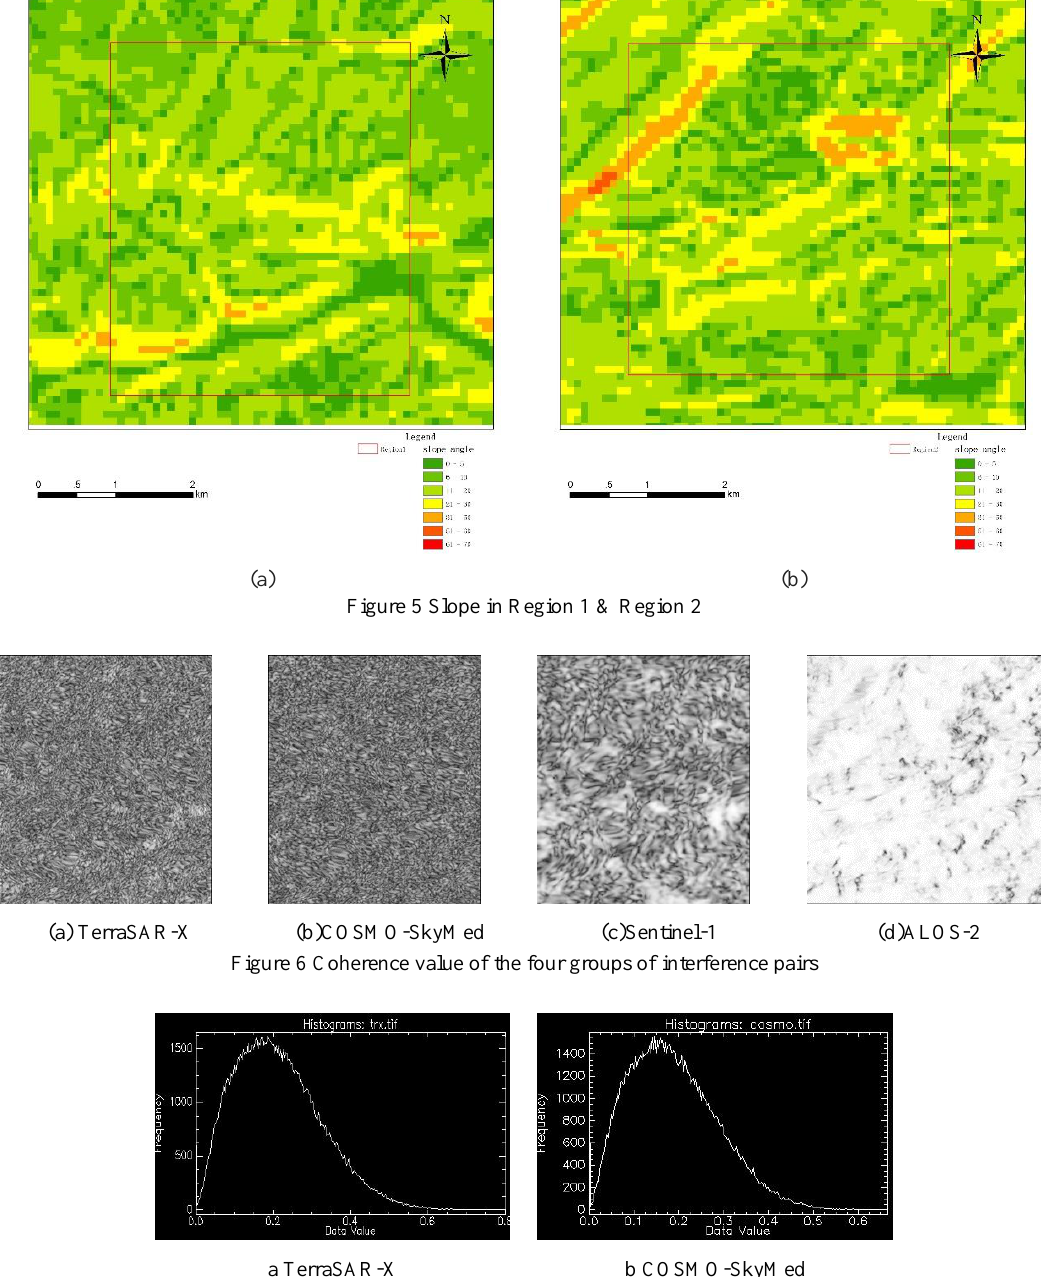
Figure 7 Histogram of the four groups of interference